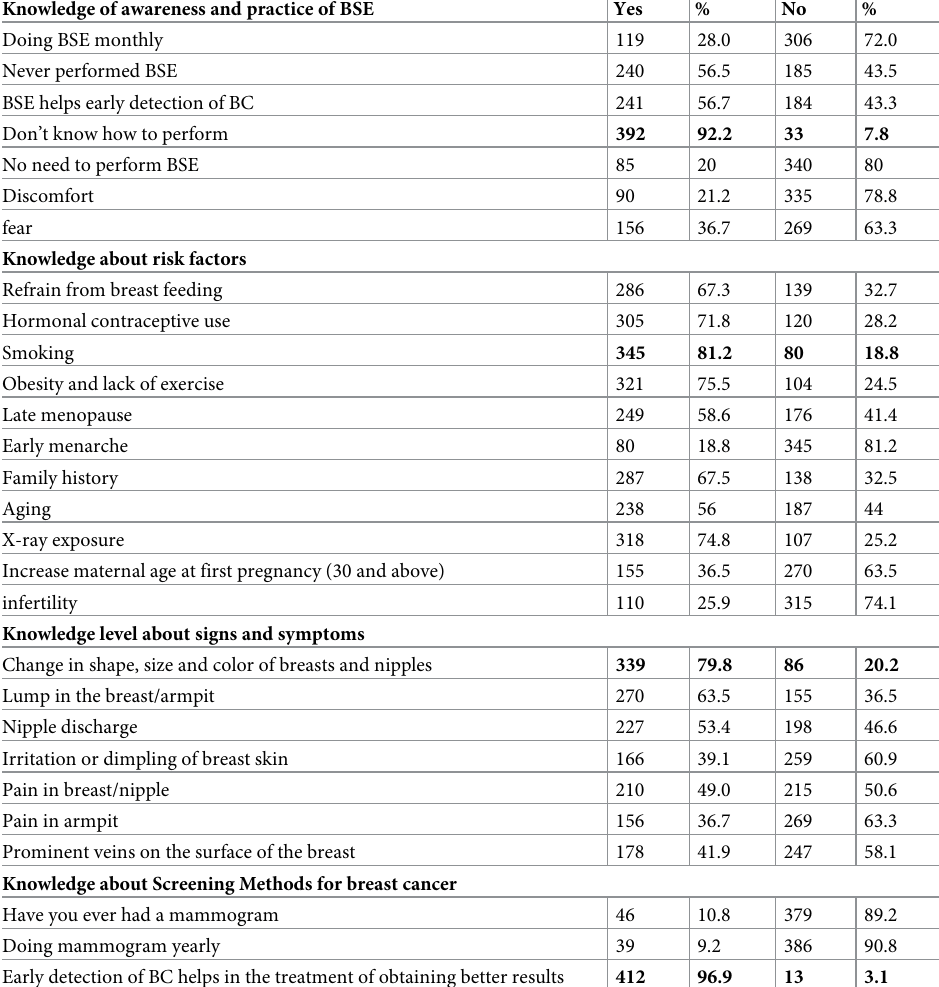
Table 4. Respondents’ knowledge on awareness and practice of BSE, risk factors, signs and symptoms and screen- ing methods in breast cancer. Knowledge of awareness and practice of